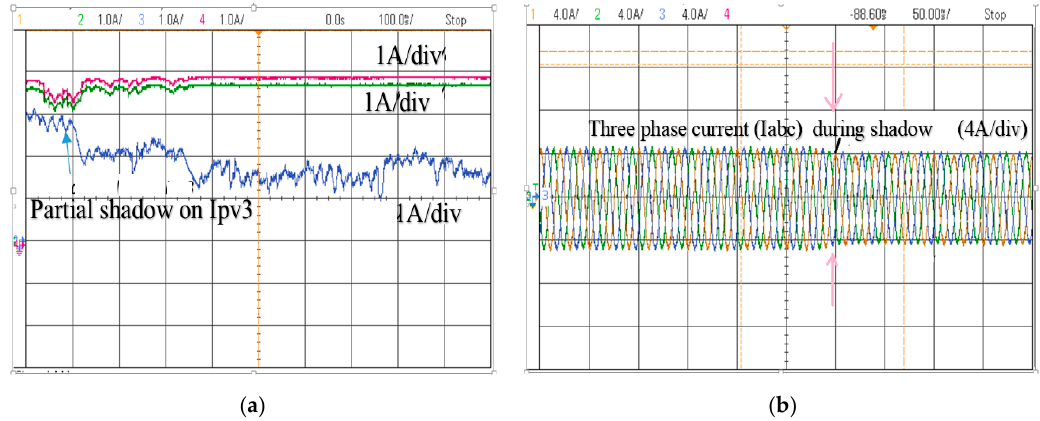
Figure 17. Experimental result for multi input operation during partial shadow: ( a ) PV current, ( b ) the